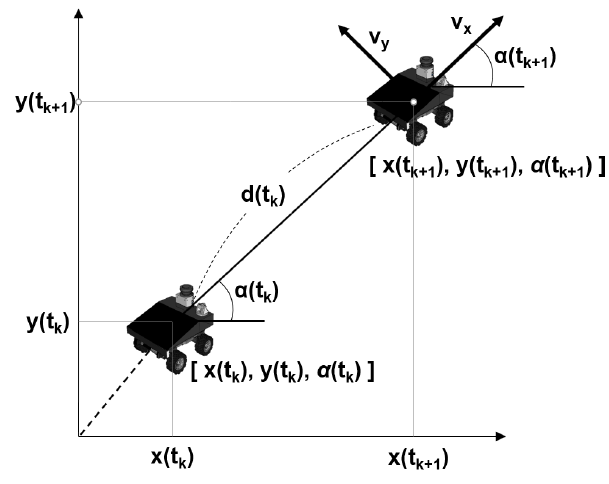
Figure 2. Two-dimensional coordinate system and dynamic model of the autonomous driving robot used in this study.